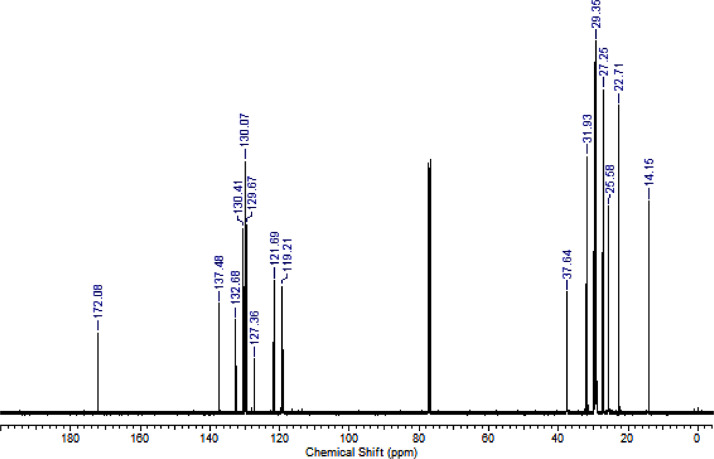
13C NMR (CDCl3, 100 MHz) spectrum of compound 11c.